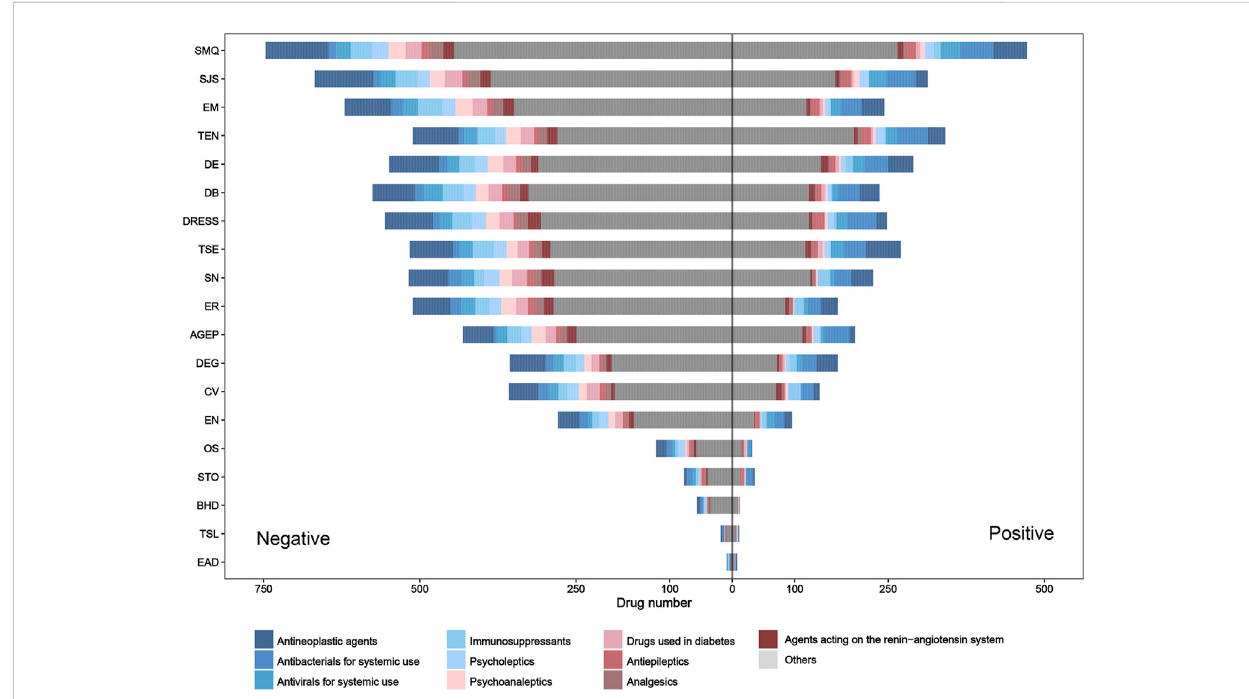
FIGURE 5 Pharmacovigilance signal distribution and drug class distribution of reported culprit-drugs at the SMQ and PT levels. AGEP, acute generalized exanthematous pustulosis; BHD, bullous hemorrhagic dermatosis; CV, cutaneous vasculitis; DB, dermatitis bullous; DE, dermatitis exfoliative; DEG, dermatitis exfoliative generalized; DRESS, drug reaction with eosinophilia and systemic symptoms; EN, epidermal necrosis; EM, erythema multiforme; EAD, erythrodermic atopic dermatitis; ER, exfoliative rash; OS, oculomucocutaneous syndrome; PT, preferred term; SMQ, Standardized MedDRA Query;STO,SJS – TENoverlap;SN,skinnecrosis;SJS,Stevens – Johnsonsyndrome;TSL,targetskinlesion;TEN,toxicepidermalnecrolysis;TSE,toxicskin